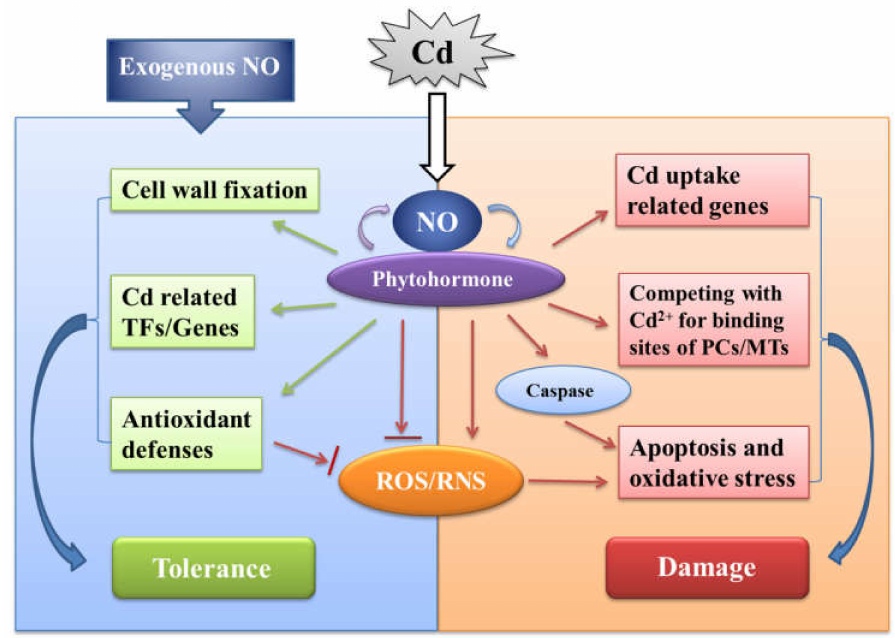
Figure 1. Schematic representation of the role of nitric oxide in the response of plants to Cd stress. TFs (transcription factors), RNS (reactive nitrogen species), ROS (reactive oxygen species), PCs (phytochelatins), MTs